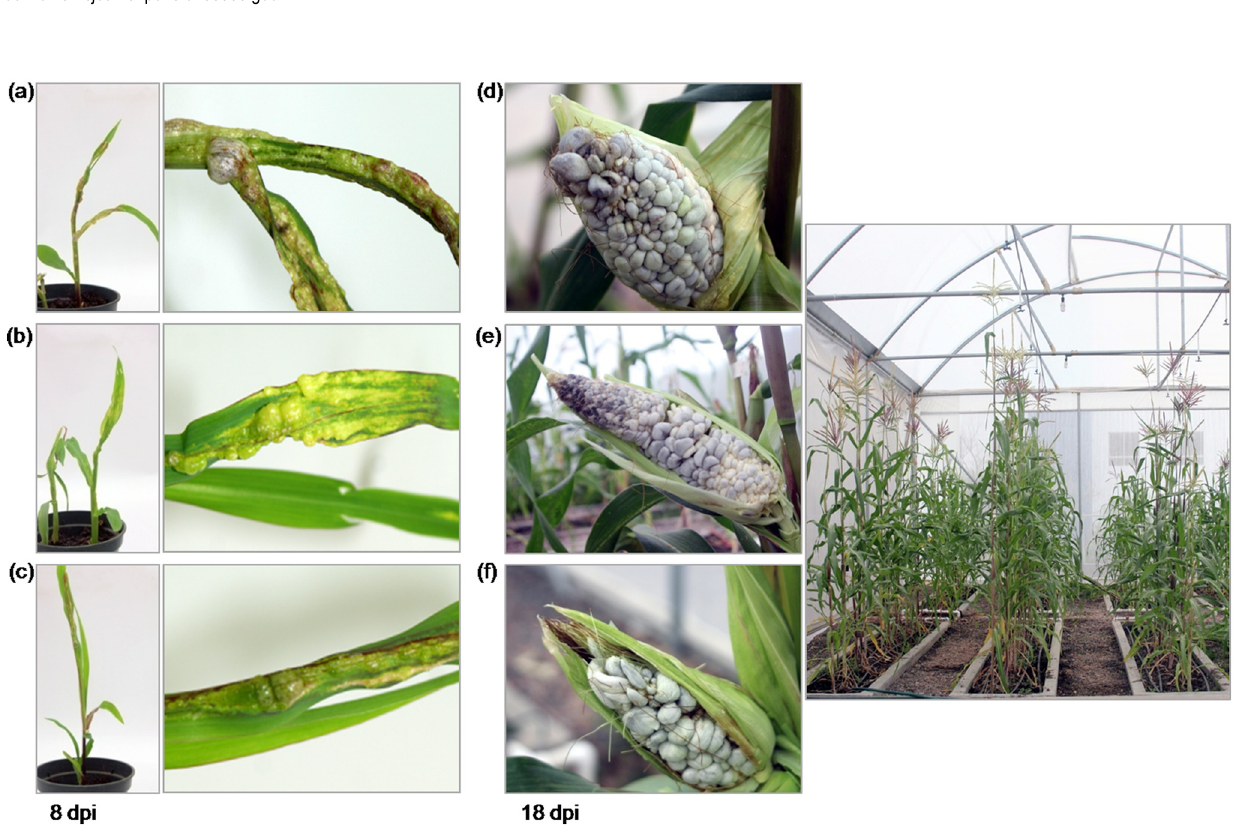
Fig 3. Tumors induced on maize plants, after inoculation with FB2-CTB strains paired with FB1 strain. Leaf tumors induced in 8-day-old maize seedlings inoculated with (a) FB1 x FB2, (b) FB1 x FB2-CTB 3 and (c) FB1 x FB2-CTB 4 crosses. Photos were taken 8 days post-inoculation (dpi). Corn smut galls ( ‘ huitlacoche ’ ) produced by inoculating with (d) FB1 x FB2, (e) FB1 x FB2-CTB 3 and (f) FB1 x FB2-CTB 4 crosses. Plants were grown under greenhouse conditions and photos were taken 18 – 20 dpi.